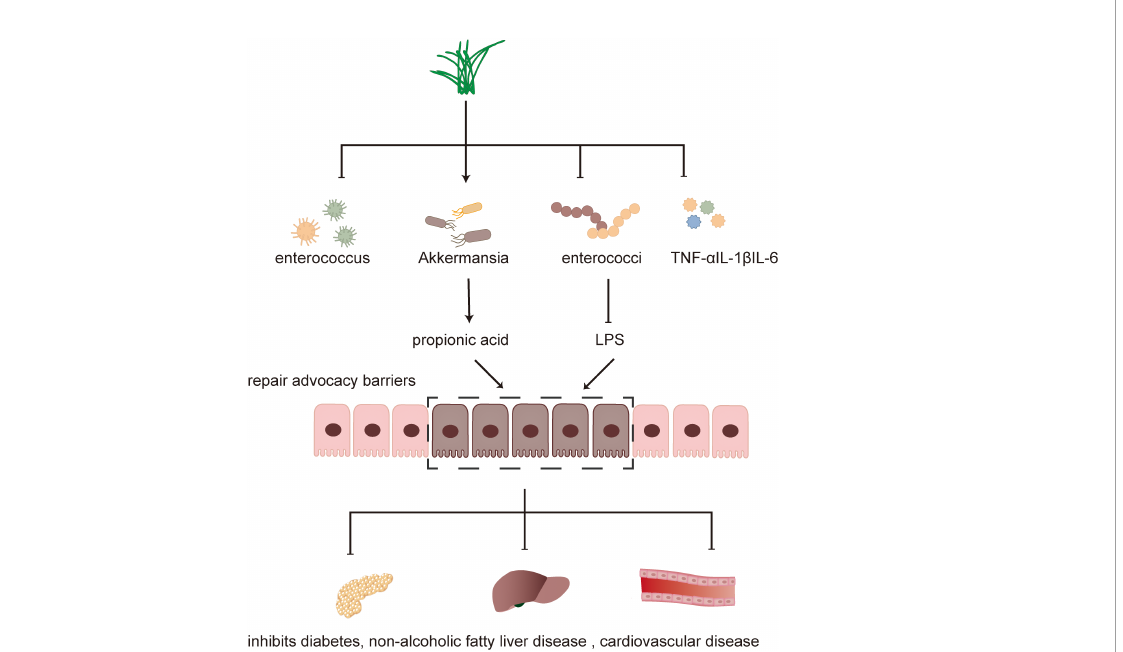
FIGURE 1 Mechanism of TCM in treating